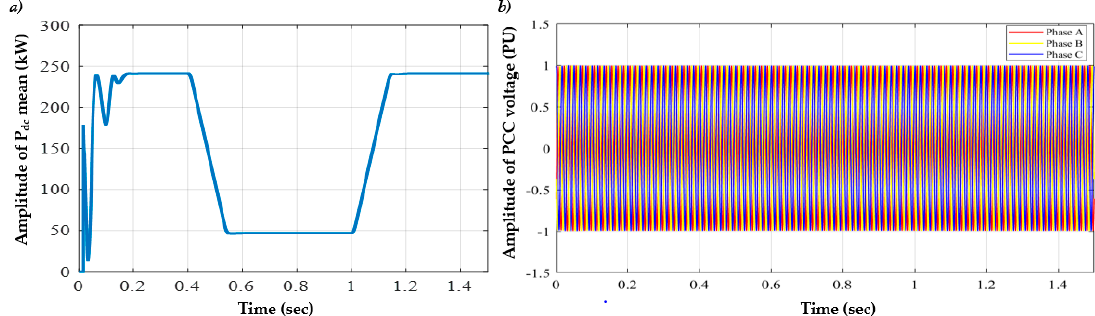
Figure 3. ( a ) Power variations observed at the output terminal of the PV array under various solar irradiance values; ( b ) 3-phase voltage waveforms at point of common coupling (PCC).